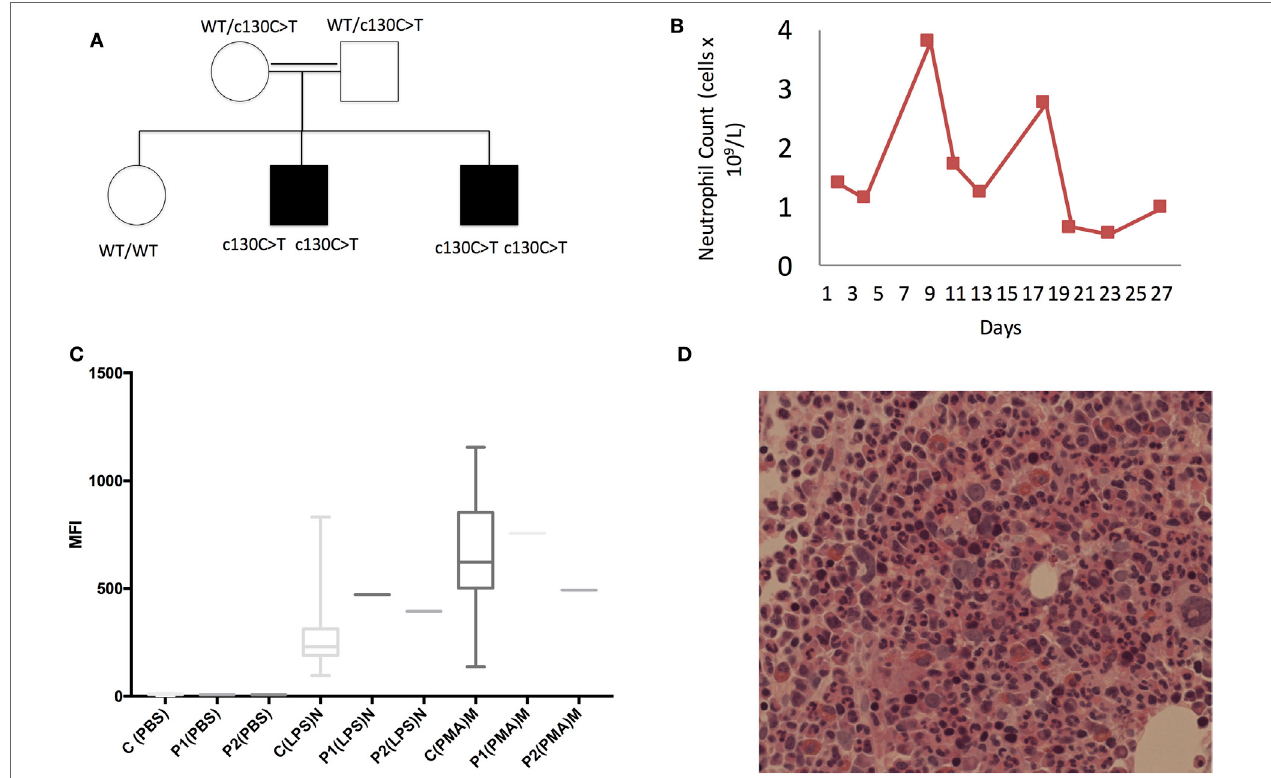
FIGURe 1 | Clinical characteristics of patients with G6PC3 c.130 C > T homozygous mutation. (a) Family pedigree, (B) longitudinal neutrophil count measurements, (C) neutrophil oxidative burst. Local reference ranges are shown in the bars. > 98% of neutrophils and monocytes showed appropriate shift following lipopolysaccharide (LPS) and phorbol myristate acetate (PMA) stimulation. (D) Histology slide from bone marrow biopsy showing normal neutrophil maturation.